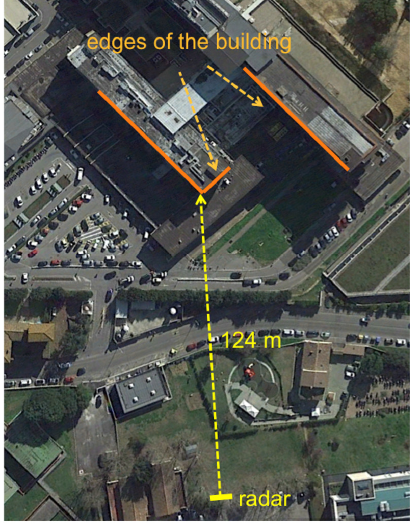
Figure 15. Aerial picture of the seven-storey building used as urban test site.